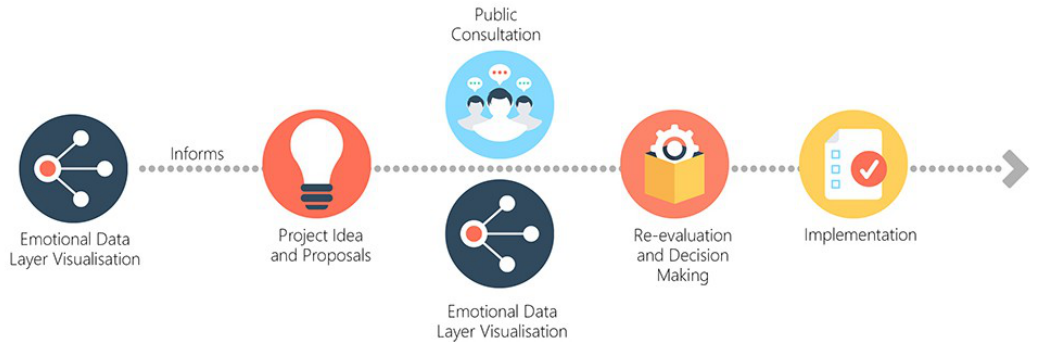
Figure 14. Emotional Data Model of participation in Urban Planning process.